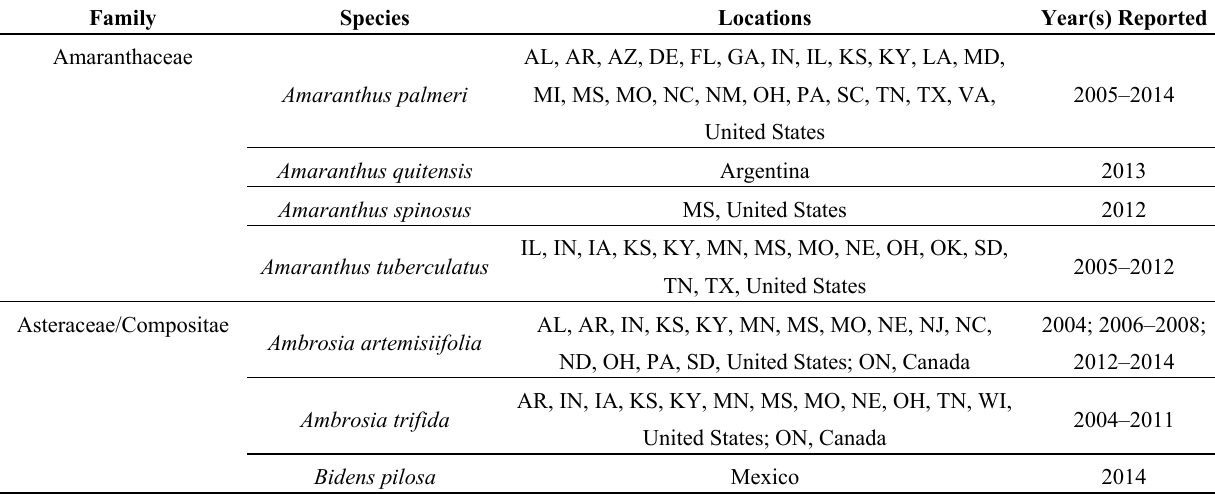
Table 3. Species, locations and year(s) of the discovery of glyphosate-resistant weed species across the world